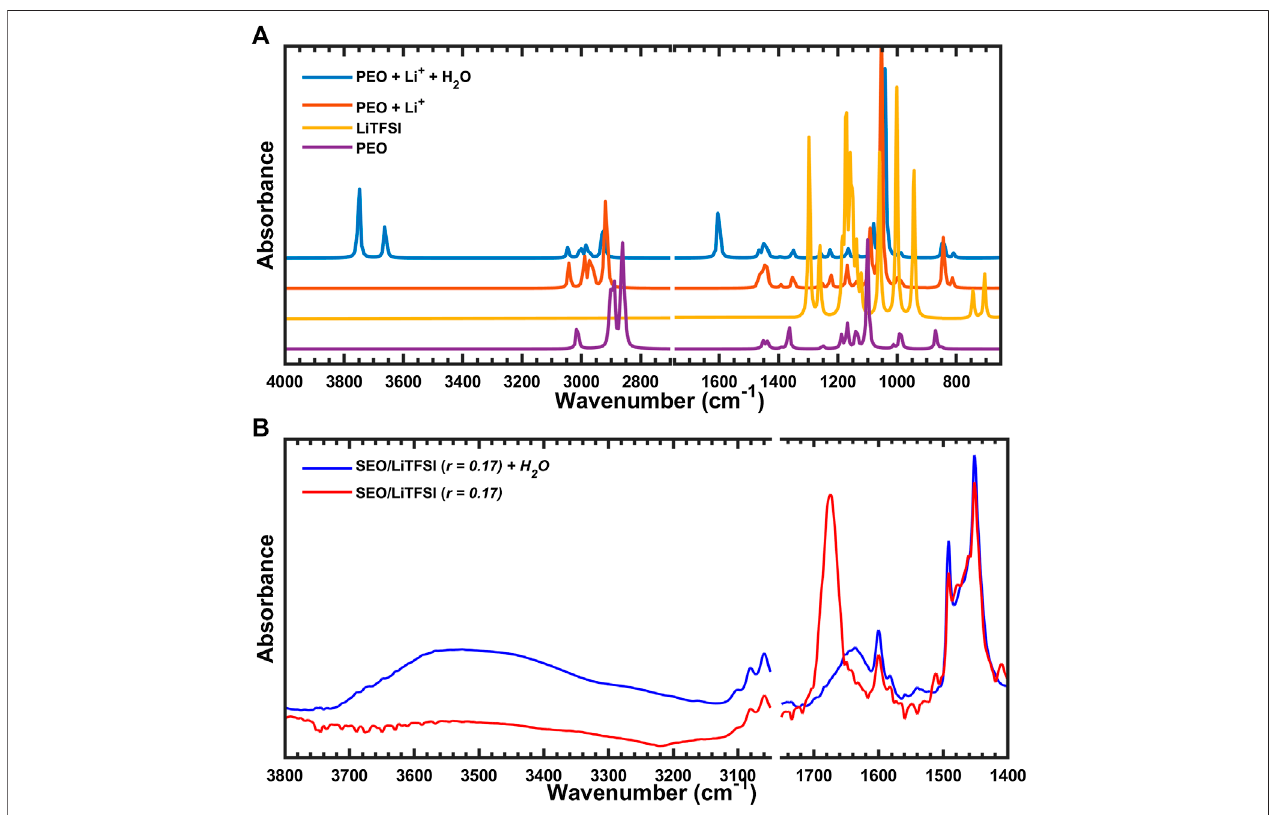
FIGURE 10 | (A) Simulated IR spectra of PEO coordinated with Li + and H 2 O, and (B) experimental FTIR-ATR spectra of SEO/LiTFSI with or without water.